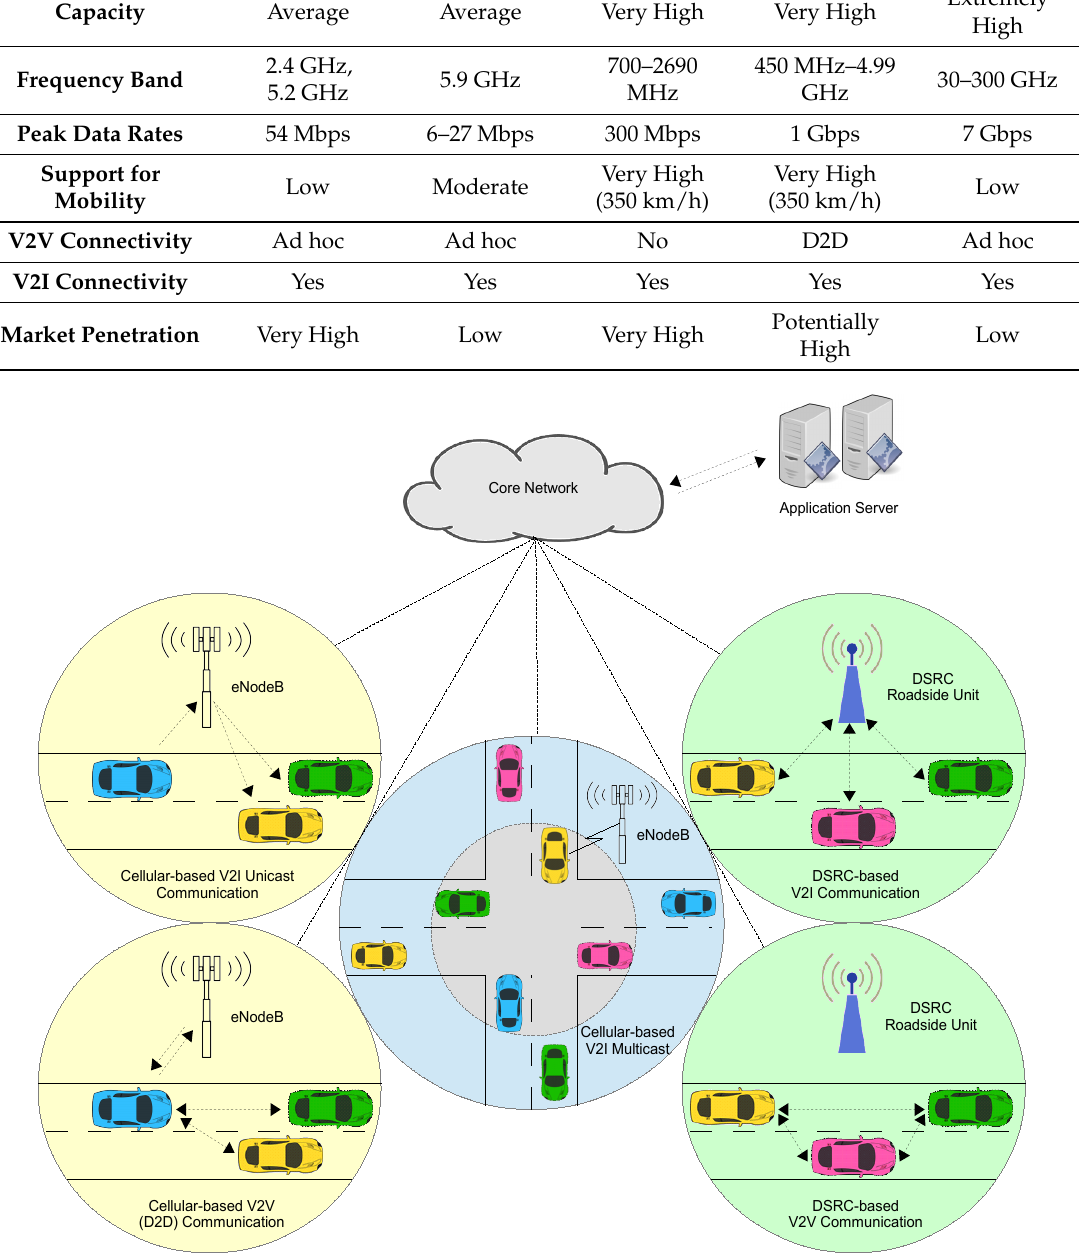
Figure 2. A heterogeneous vehicular networking